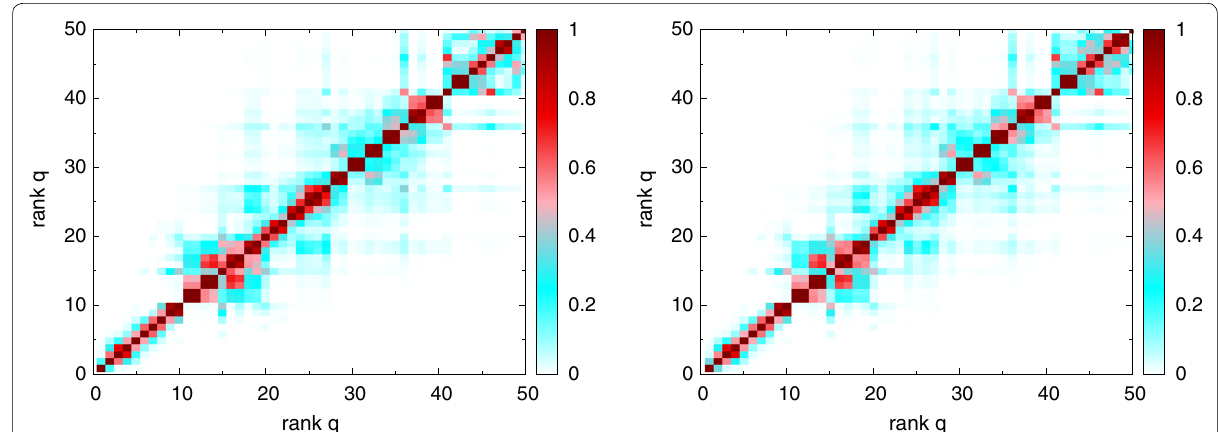
Fig. 14 The weighted correlation matrix. Red colors represent stronger correlation between eigenvectors and therefore a weaker separation. The color scale corresponds to absolute values of correlations from 0 (white) to 1 (dark red)